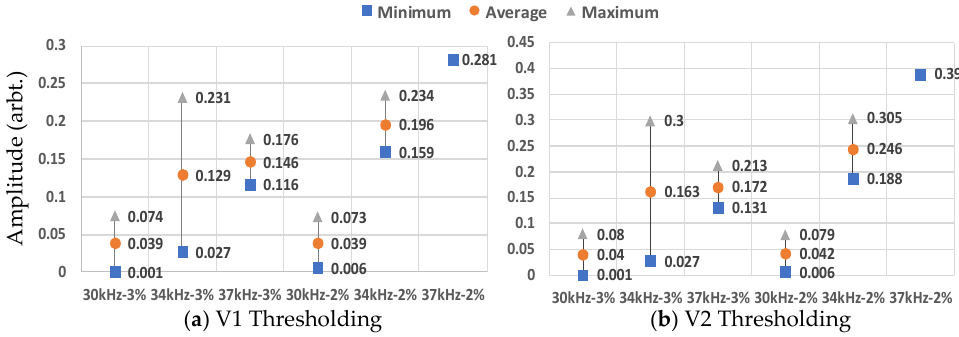
Figure 12. Limits achieved using method two on the first set of tests.